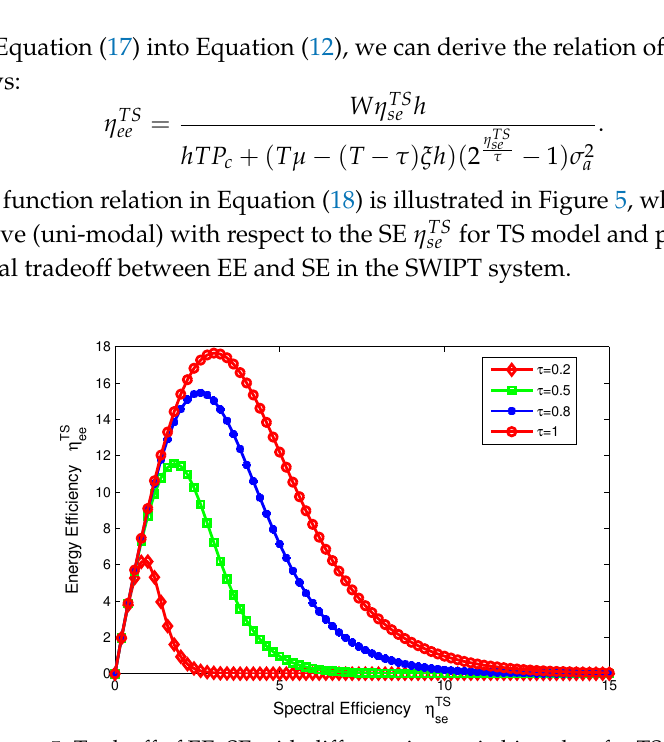
Figure 5. Tradeoff of EE–SE with different time switching slots for TS